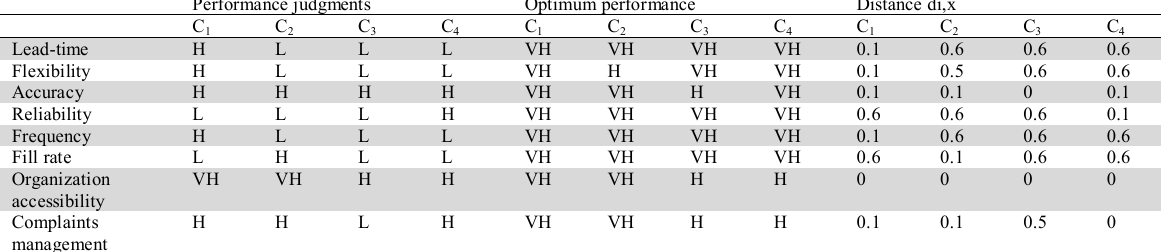
Complaints management Weighted importance W i* of each service factor